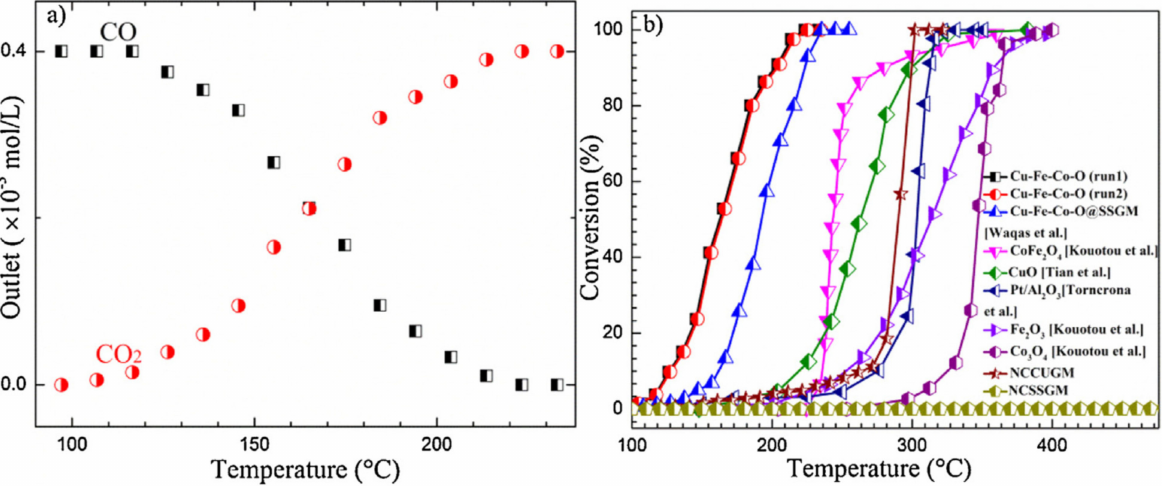
Figure 13. Temperature dependence of CO conversion over Cu-Fe-Co ternary oxide ( a ) and the catalytic performance for CO total combustion over different systems including Cu-Fe-Co-O@CUGM (run 1 and run 2, this work), Cu-Fe-Co-O@SSGM, CoFe 2 O 4 , CuO, Pt/Al 2 O 3 , Fe 2 O 3 , and Co 3 O 4 ( b ) (reproduced from Ref.